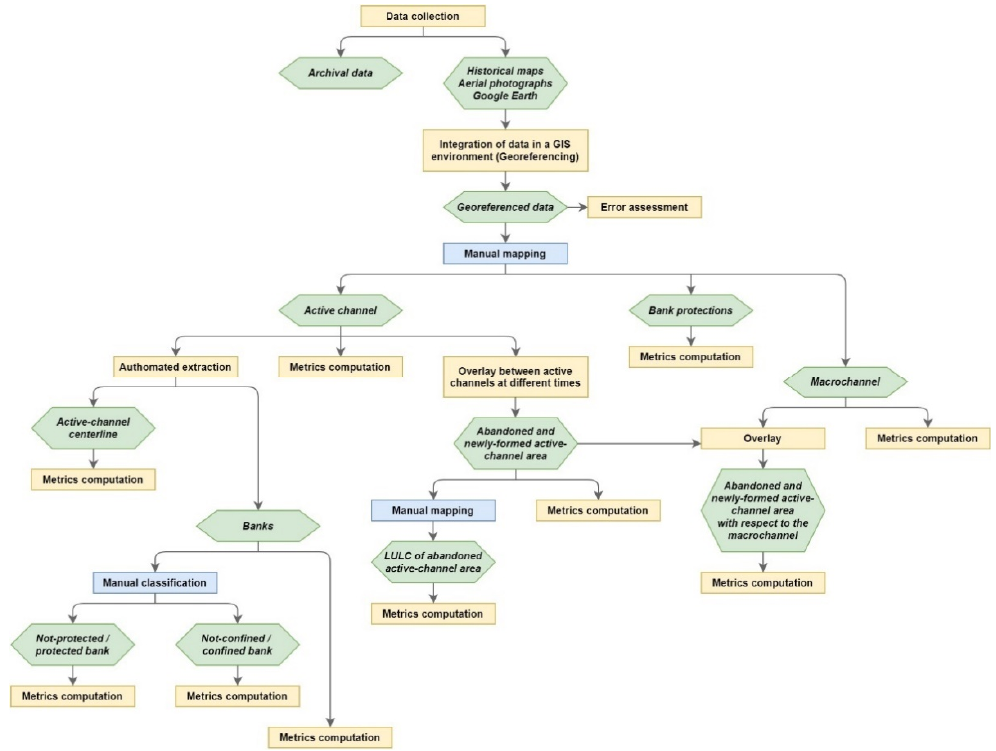
Figure 2. Schematization of the methodological framework. Hexagon (rectangle) indicates input/output data (process). Blue rectangle indicates that field surveys and, for historical features, archival data supported and validated the process. Table 1. Data sources used in the present study. The scale values marked with * indicate the scale of visualization. ** Plugin source: https://nextgis.com/blog/quickmapservices/ (accessed on 13 January 2021). B/W = black/white; C = coloured; WMS = Web Map Service.